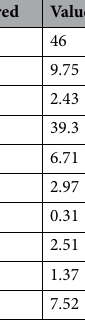
Table 2. Physico-chemical characterization of fly